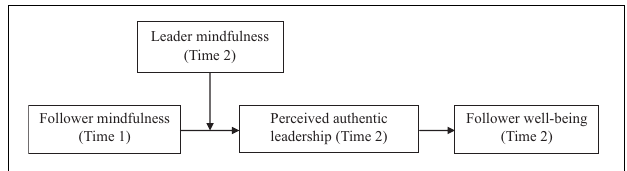
FIGURE 1 | The hypothesized